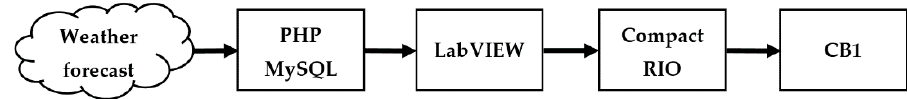
Figure 9. Controlling the energy flow in the microgrid, using the data extracted from the applied weather forecast source.